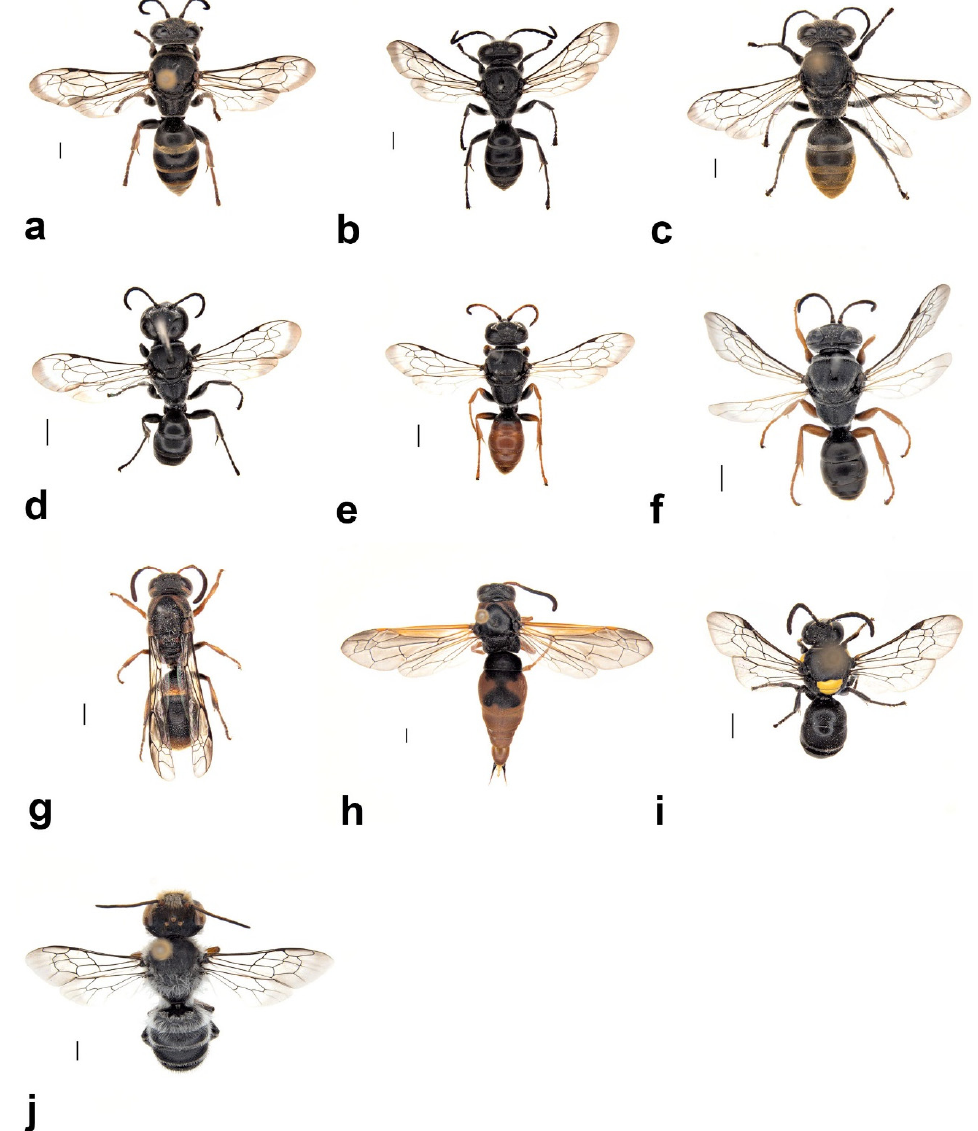
Figure 9. Adults of secondary tenants that are associated with the use of S. formosum mud nests: ( a ) Pison simillimum; ( b ) Pison spinolae; ( c ) Pison auriventre; ( d ) Pison priscum; ( e ) Pison peletieri; ( f ) Pison prostratum; ( g ) Paralastor sp.; ( h ) unknown species of Eumeninae wasp; ( i ) Hylaeus nubilosus; ( j ) Megachile aurifrons. Scale bar = 1 mm.